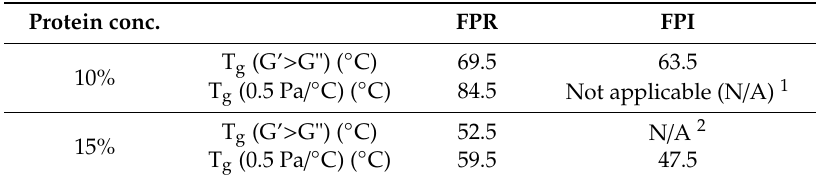
Table 3. Gelation onset temperature (T g ), including G’ > G” crossover temperature and temperature, where rate of G’ increase reaches 0.5 Pa / ◦ C.